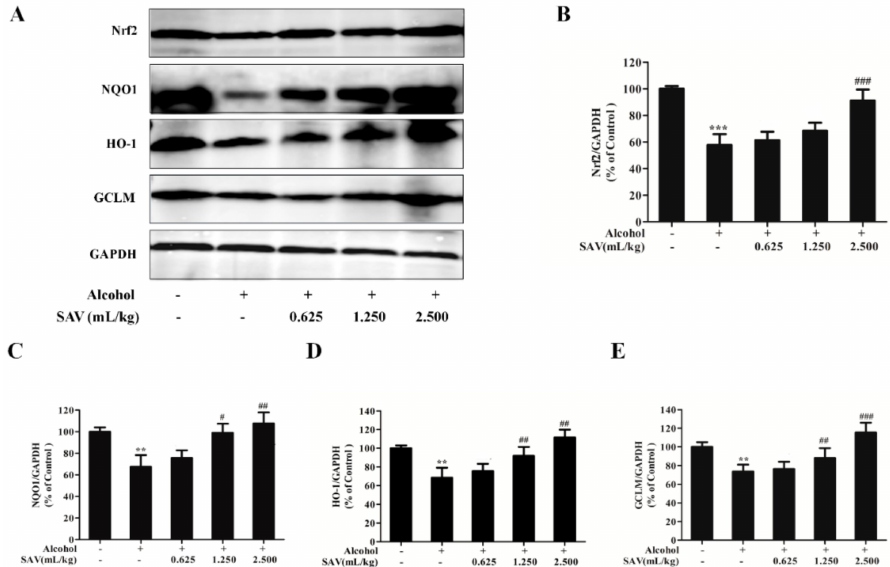
Figure 3. Effect of SAV on the Nrf2-mediated antioxidant response. ( A ) The expression levels of Nrf2, NQO1, HO-1 and GCLM in livers were measured by western blot analysis; ( B ) Quantification of Nrf2 expression; ( C ) Quantification of NQO1 expression; ( D ) Quantification of HO-1 expression; ( E ) Quantification of GCLM expression. All data are expressed as mean ± SEM ( n = 5–7). ** p < 0.01 versus control group, *** p < 0.001 versus control group, # p < 0.05, ## p < 0.01, ### p < 0.001 versus ethanol